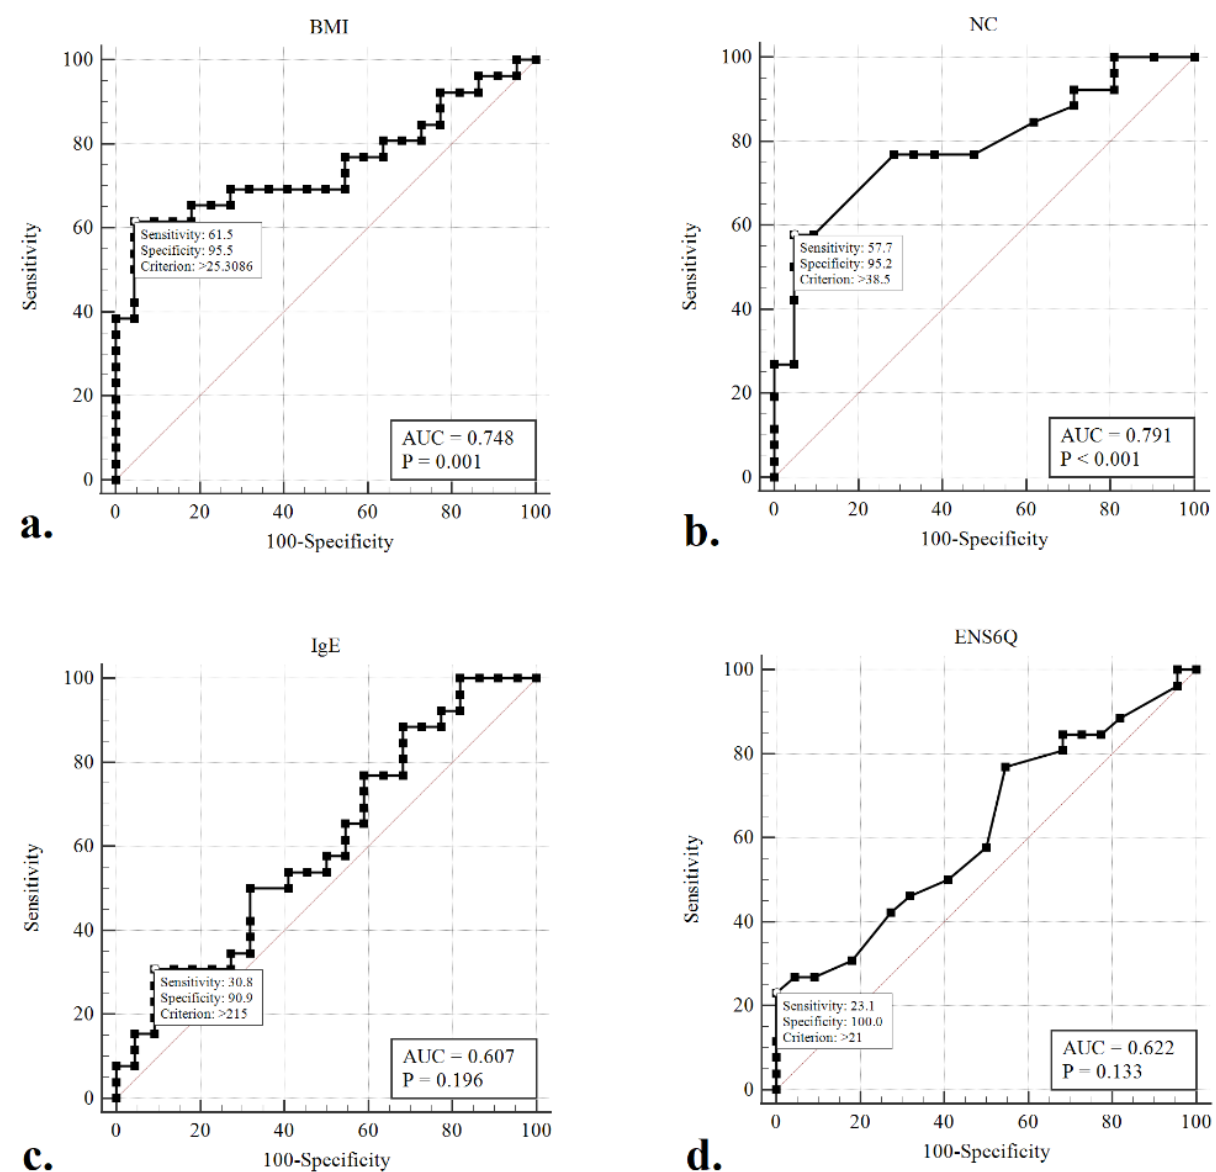
Figure 2. Receiver operating characteristic (ROC) curves to detect moderate-to-severe obstructive sleep apneoa (AHI > 15) using the variables of BMI ( a ), NC ( b ), sIgE ( c ), and ENS6Q ( d ). The optimal cut-offs for these metrics (maximizing the sum of sensitivity and specificity) are indicated.